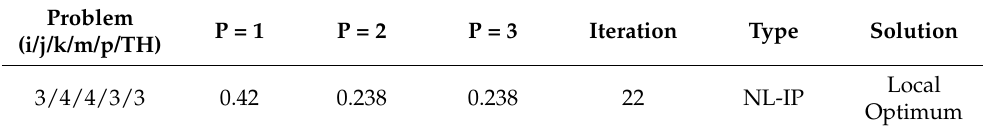
Table 8. Results of solving the case studies with Lp-Metric method ( p = 1, 2, 3).